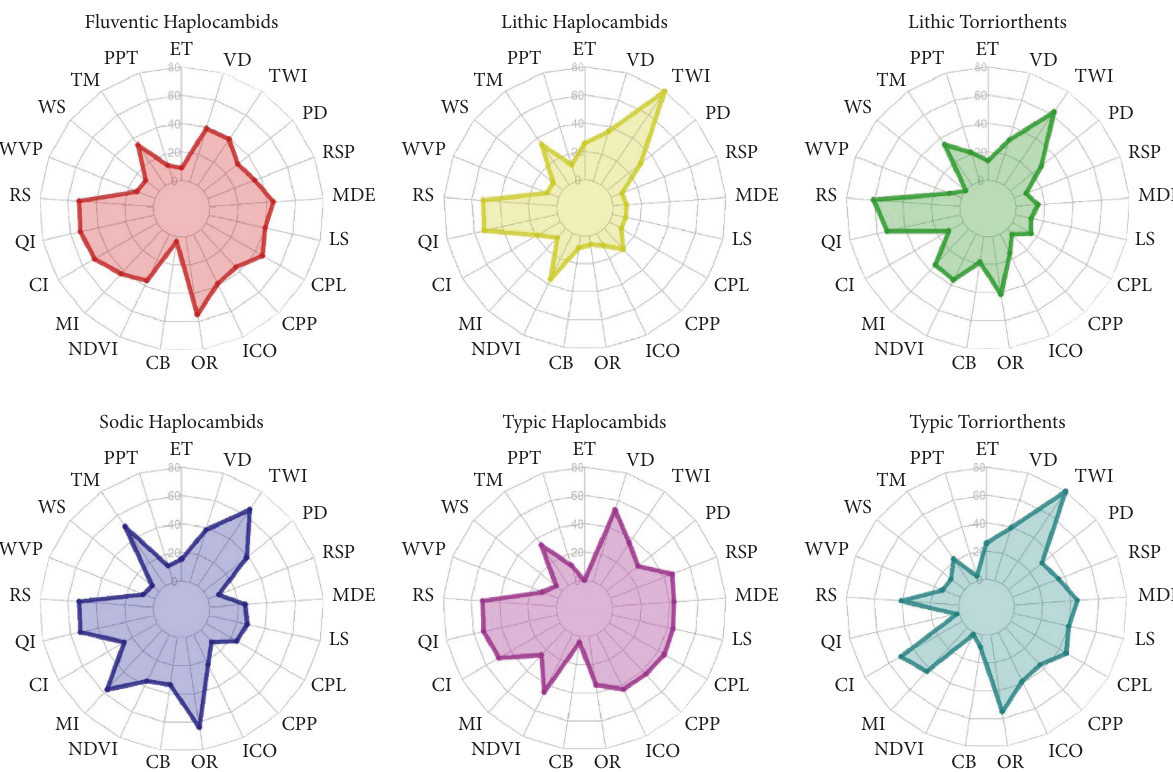
Figure 5: The relative importance of predictors on soil